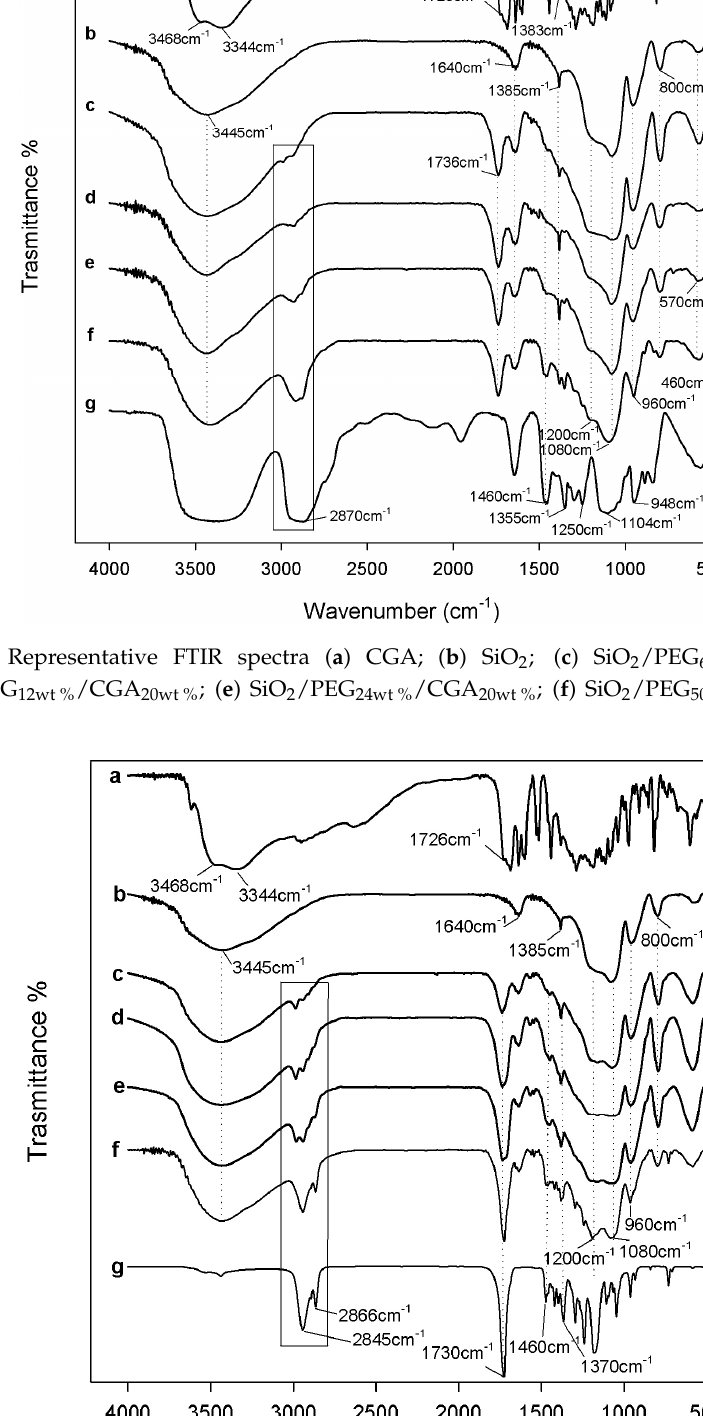
Figure 4 . Representative FTIR spectra ( a ) CGA; ( b ) SiO 2 ; ( c ) SiO 2 /PCL 6 wt % /CGA 20 wt % ; ( d ) SiO 2 /PCL 12 wt % /CGA 20 wt % ; ( e ) SiO 2 /PCL 24 wt % /CGA 20 wt % ; ( f ) SiO 2 /PCL 50 wt % /CGA 20 wt % ; ( g ) PCL.